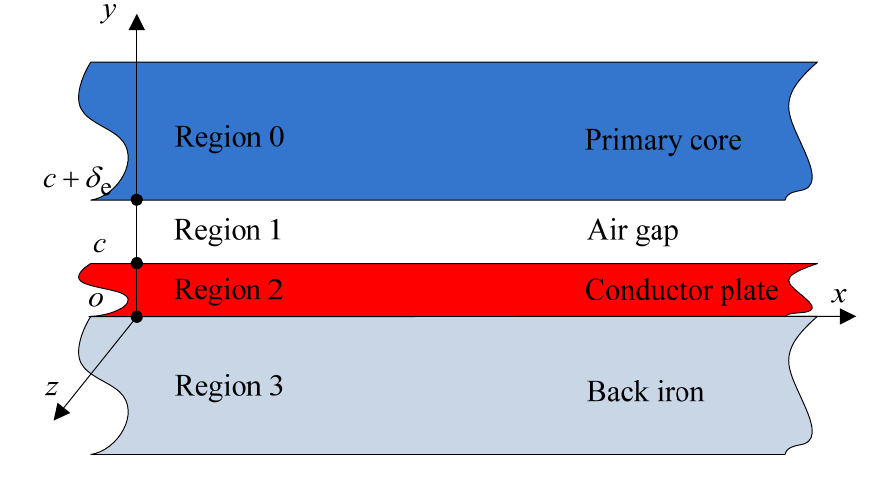
Figure 5. Two-dimensional multi-layer